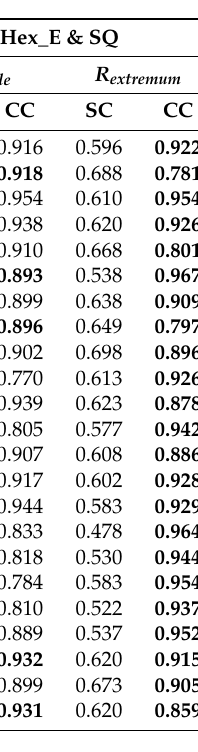
Table 5. The R saddle and R extremum values for SC and CC between SQ_E, SQ and Hex_E image types.